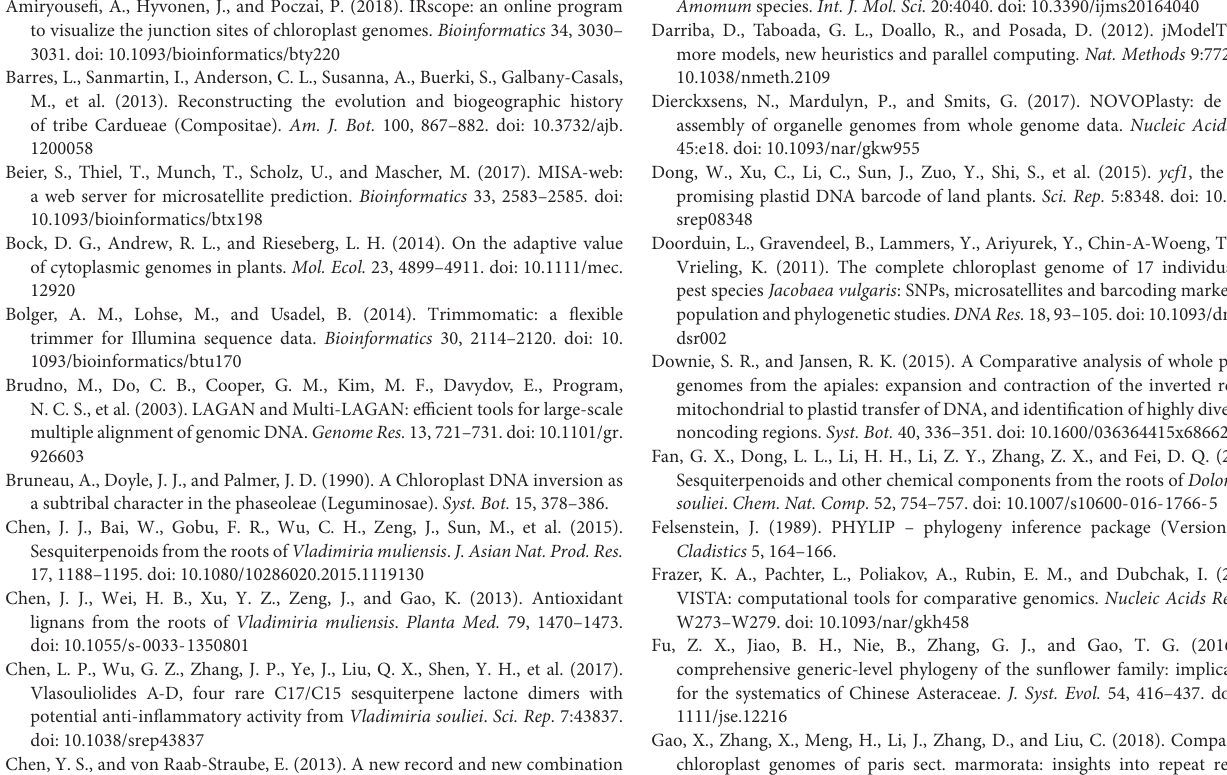
FIGURE S1 | Phylogenetic reconstruction of Cardueae from partitioned maximum likelihood (ML) and Bayesian inference (BI) analyses using concatenated 79 protein-coding regions. The ML tree is shown. Maximum likelihood bootstrap values (BS) and posterior probabilities (PP) are shown at nodes. Branches with no values listed have 100% BS and PP of 1.00.